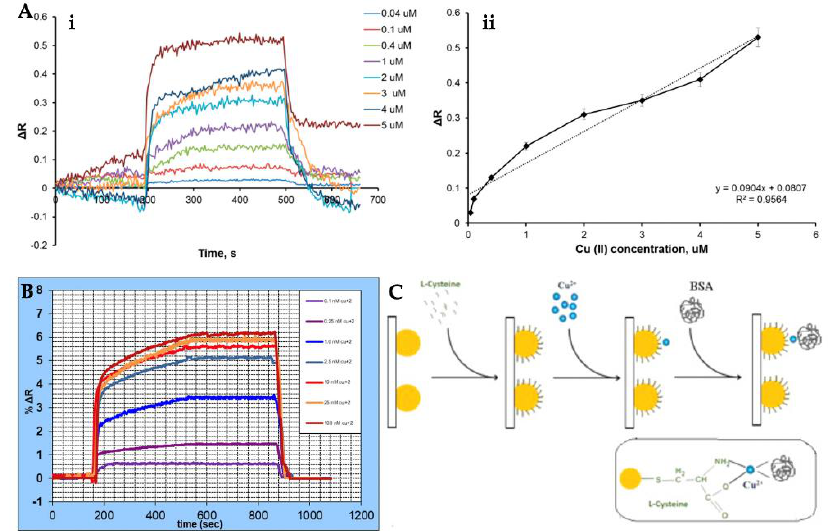
Figure 5. Real-time detection by Cu 2+ -imprinted SPR sensor ( A ), % ∆ R values of SPR sensor versus time at several concentrations of Cu 2+ ion ( B ), and the illustration for LSPR-based Cu 2+ ion detection ( C ). Republished with permission from [147,148,152].